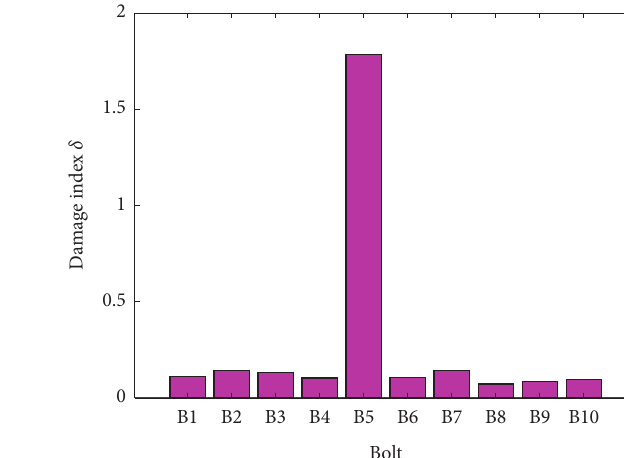
Figure 10: Histogram of bolt looseness damage index.